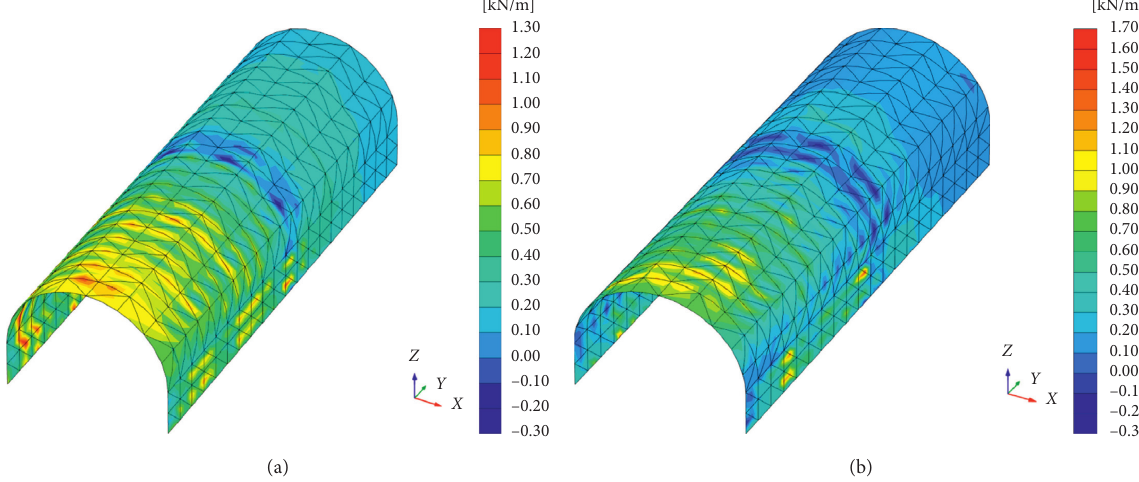
Figure 5: Geogrid axial force cloud diagram: (a) full-face excavation method; (b) two-step excavation method.